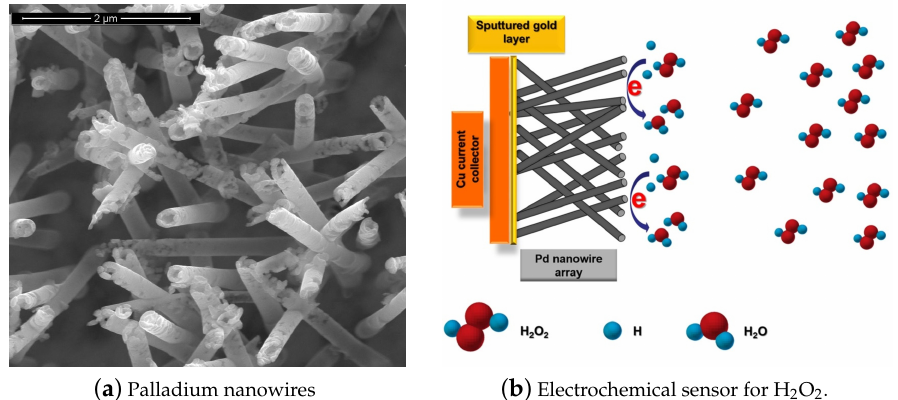
Figure 1. Electrochemical hydrogen peroxide (H 2 O 2 ) sensor based on palladium nanowires (PdNWs). ( a ) SEM micrograph of the PdNWs electrode, ( b ) basic diagram of the sensor operation. With permission from